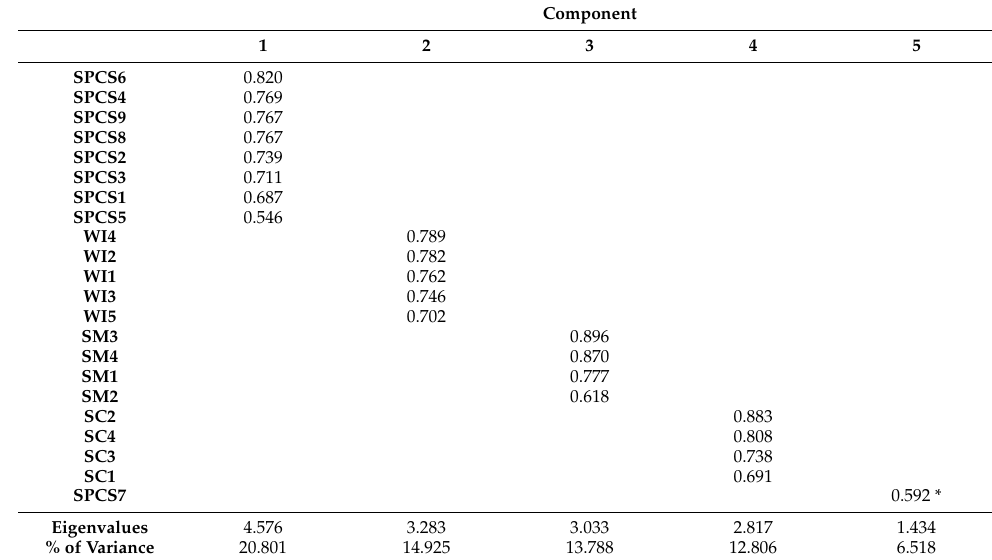
Table 3. Factor loadings for 22 CSF items (N =